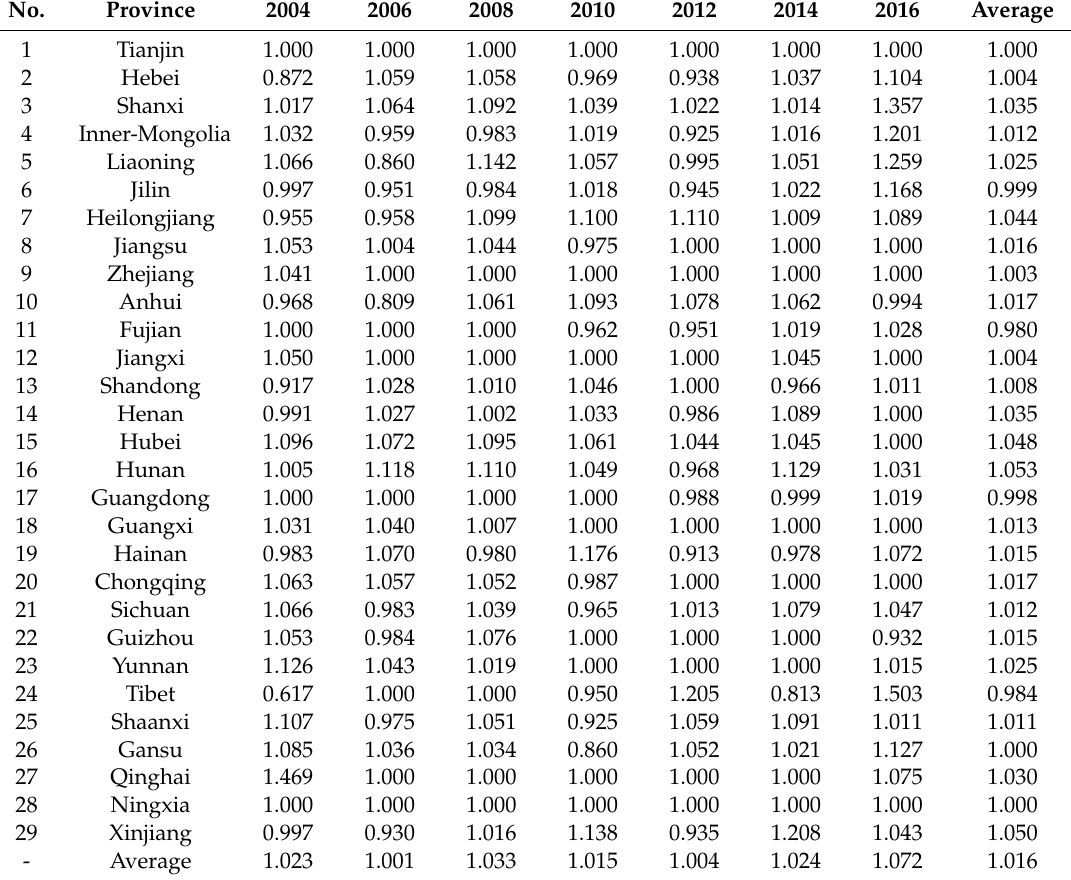
Table 3. Provincial e ffi ciency change through Malmquist index of Chinese township hospitals